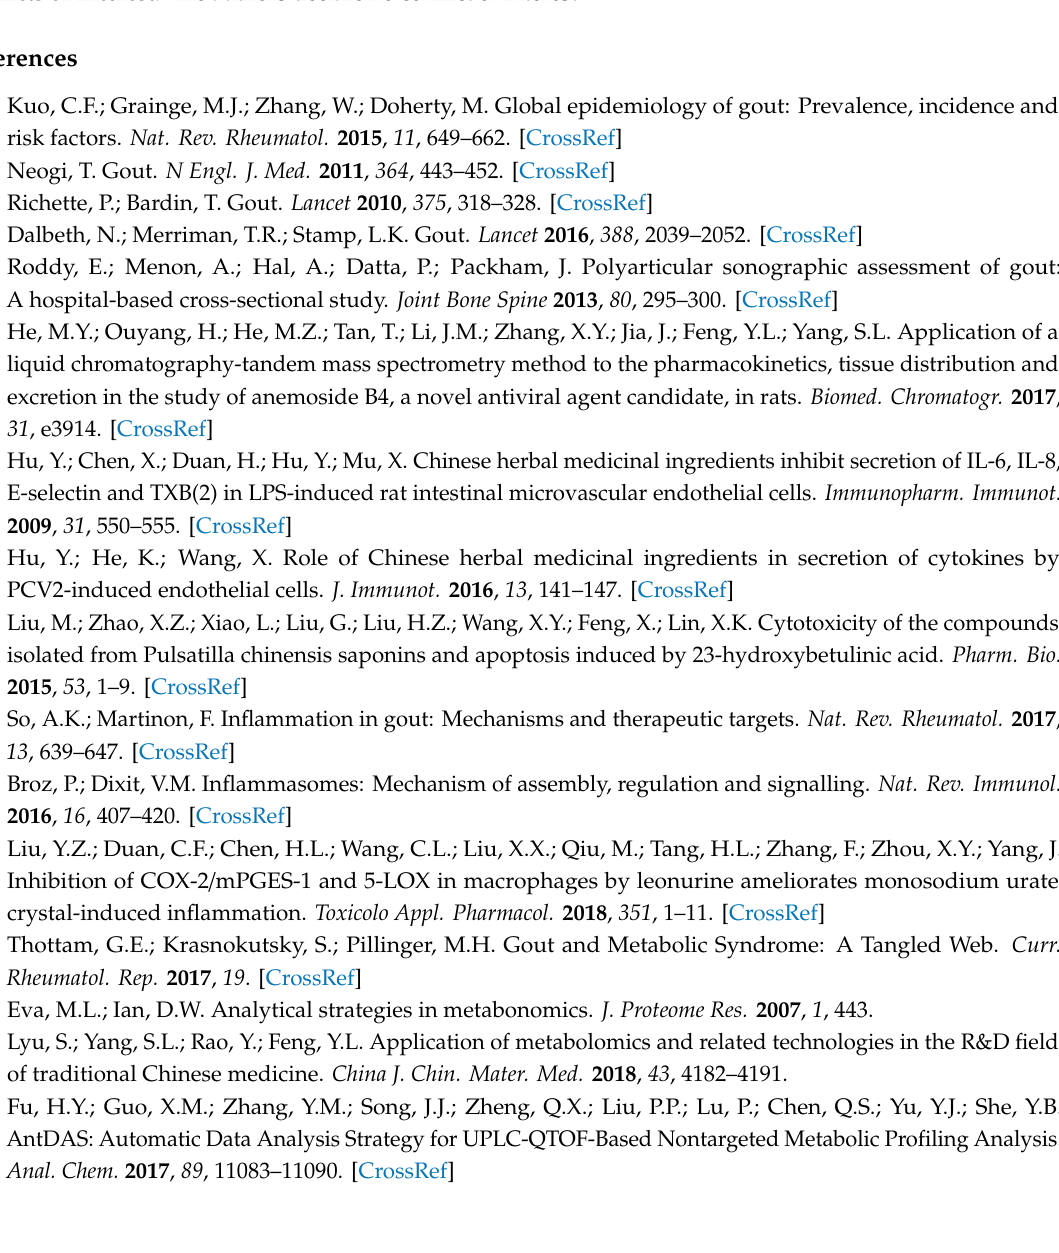
Figure S1. The bar plot of the value of each group on toes / ankle swelling and pain threshold. Figure S2: The TICs of 6 QC samples, Figure S3: The permutation of 200 tests of 12 OPLS-DA models, Table S1: Detailed structure elucidation data (NMR) of P-b4, Table S2: The R2 and Q2 of 12 OPLS-DA models, Table S3: The Metabolic pathway analysis results (using KEGG pathway database), Table S4: The verification information of identified metabolites, Table S5: CV-ANOVA of 12 OPLS-DA score